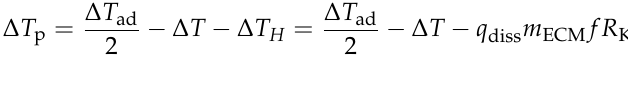
Figure 4. The temperatures for the analytical model from a stationary perspective: of ∆ T H , the difference in temperature compared with the environment; ∆ T , the temperature span of the AEH; and ∆ T p , the temperature span for pumping